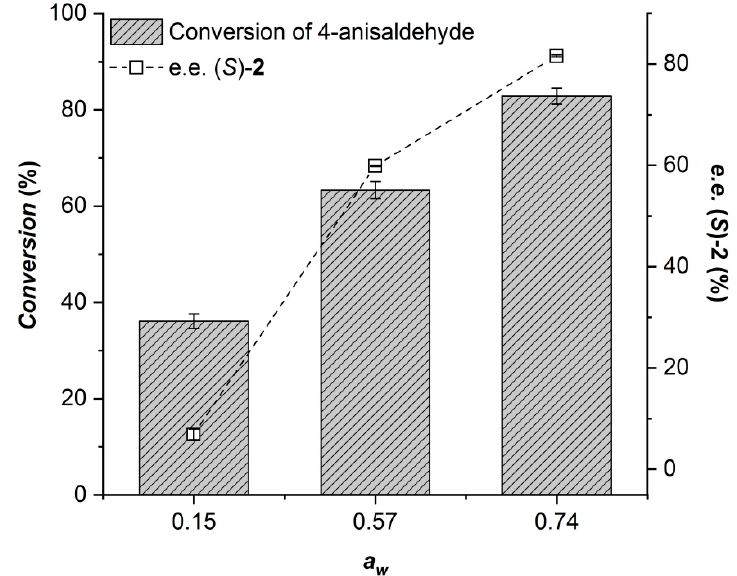
Figure 3. Effect of water activity on the Me HNL-catalyzed hydrocyanation of 90 mM 4-anisaldehyde using 6.5 equivalents of HCN. Conversion and enantiomeric excess (e.e.) values taken after 23 hours of reaction.